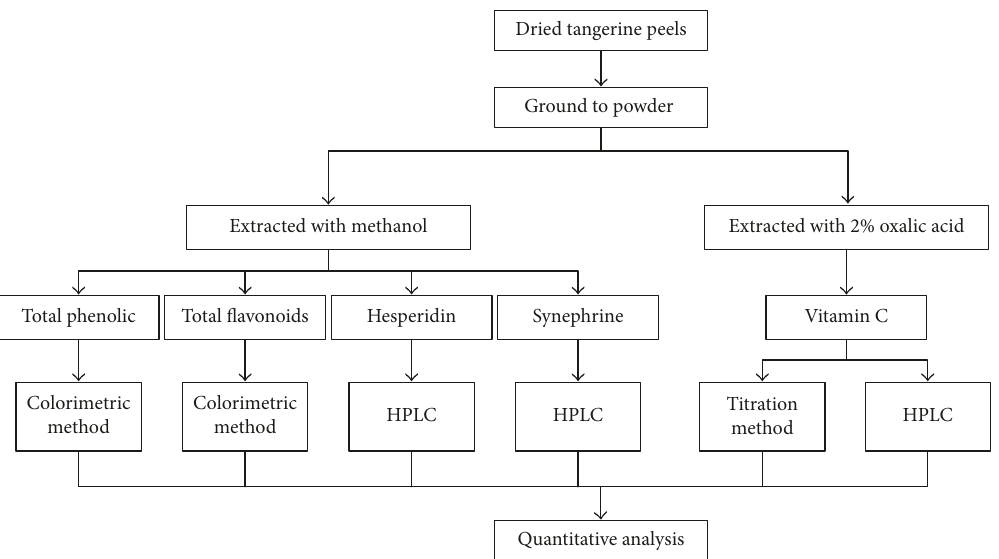
Figure 1: Flowchart of extracting of total phenolics, total flavonoids, hesperidin, synephrine, and vitamin